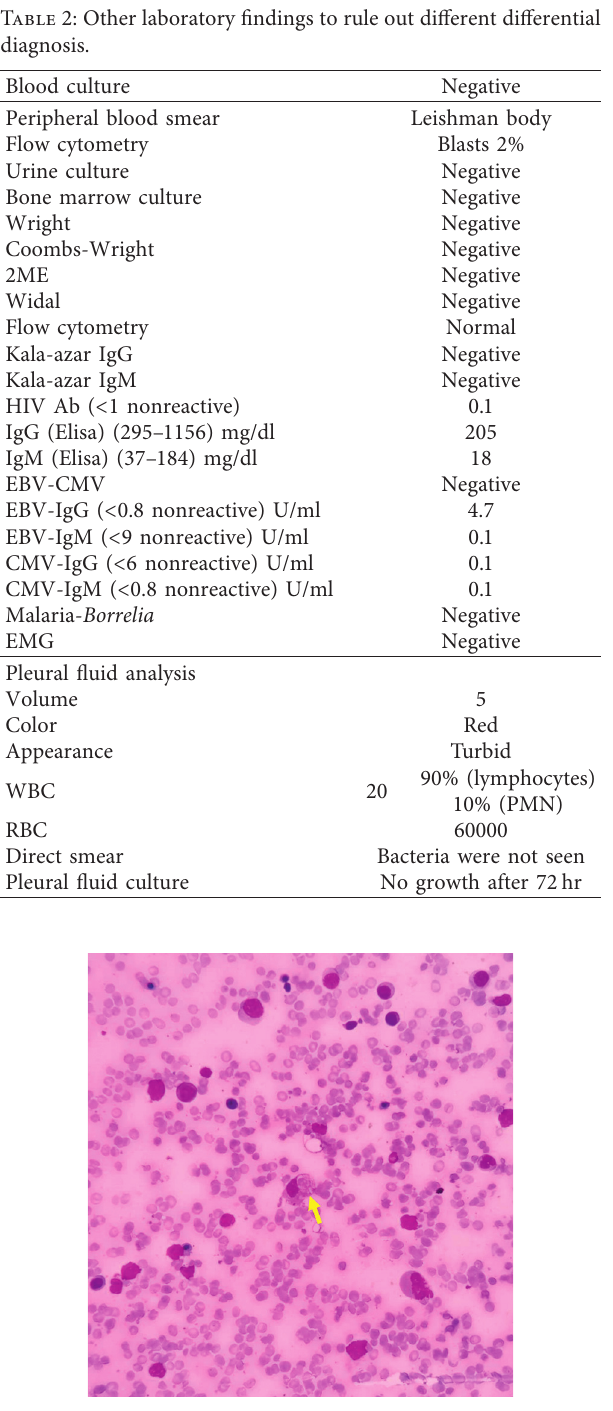
Figure 3: Bone marrow aspiration smear: a histiocyte with engulfed red blood cell and a Leishman Donovan like body (Giemsa